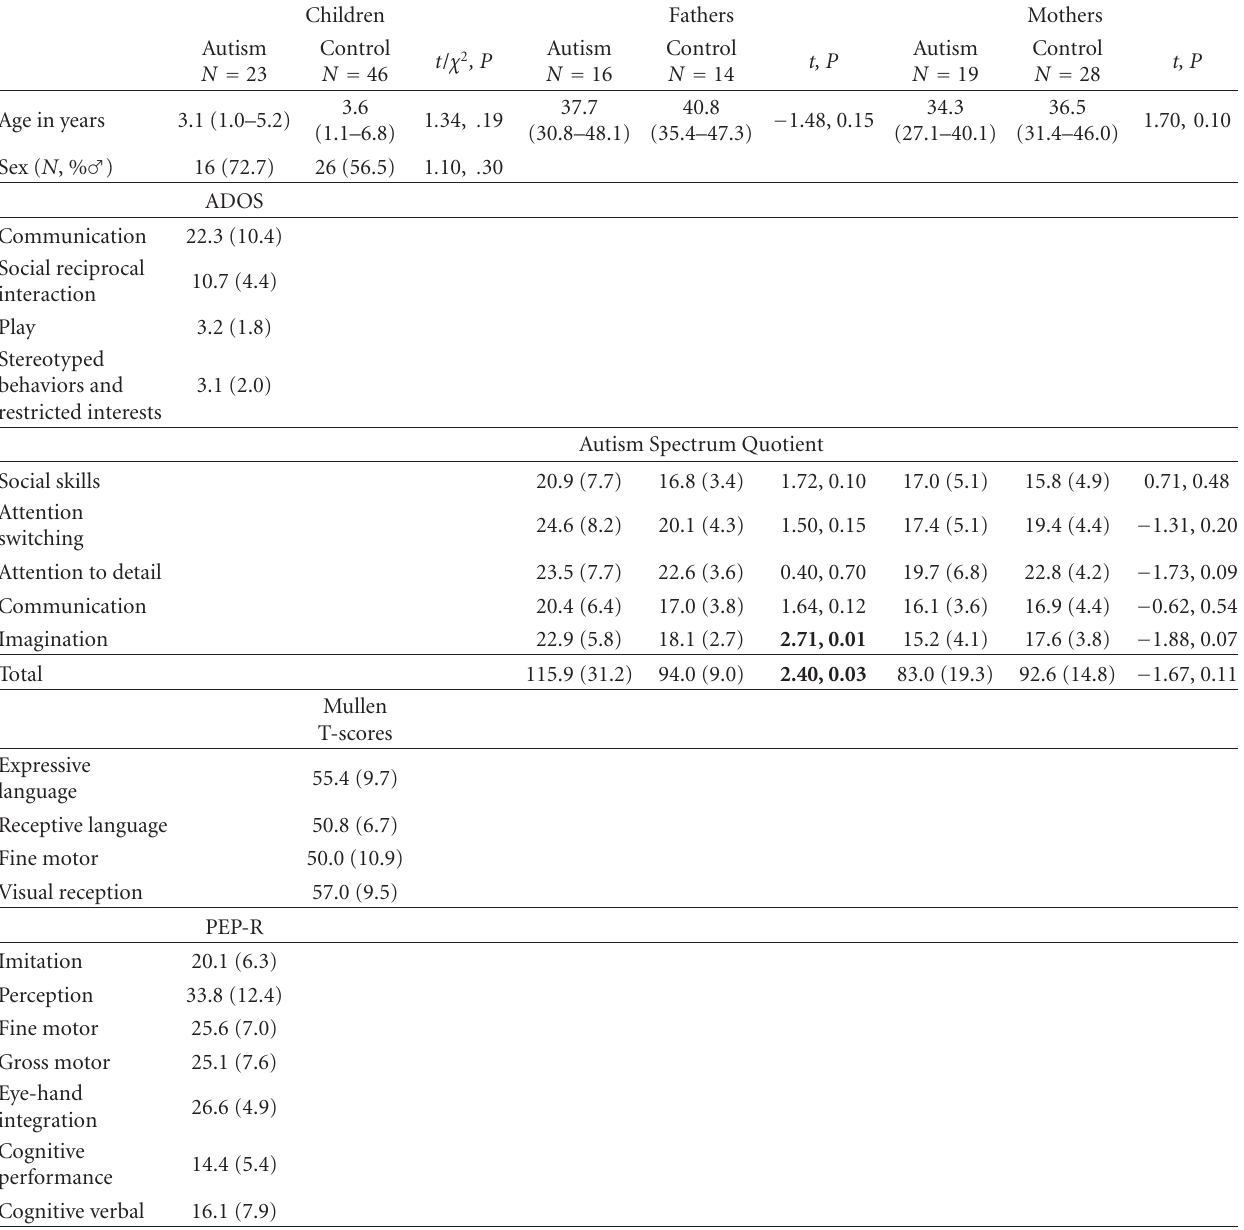
watching times within the ROIs, and SPSS (version 17) was for statistical testing. The Rabbit puzzle movie (duration: 33 s) showed nine puzzle pieces that moved from the left and right side into the screen to form a photorealistic picture of a rabbit with a carrot (Figure 1). When the ninth piece moved into place at t = 24 s, the picture unfroze and showed a rabbit eating the carrot. ROIs were the eye and the ears of the rabbit and the carrot. As the ears and the eye were visible from t = 10–33 s, their corresponding ROIs started at t = 10 s and ended at t = 33 s. The carrot ROI started at t = 15 s and ended